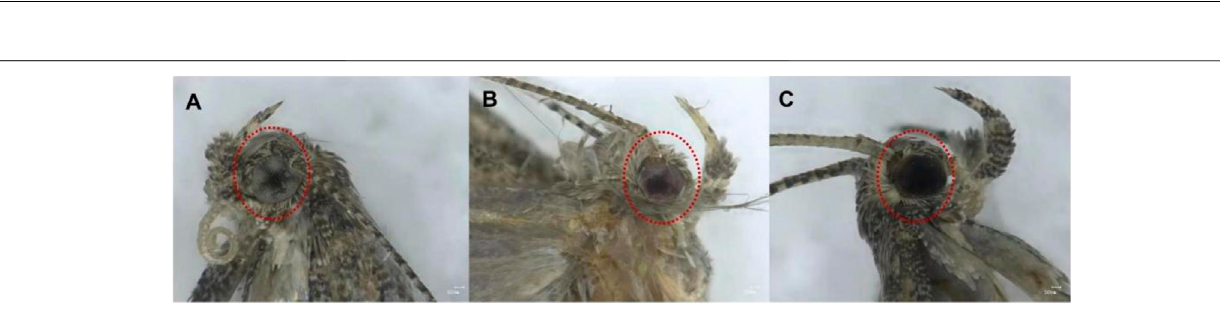
Frontiers in Genetics |